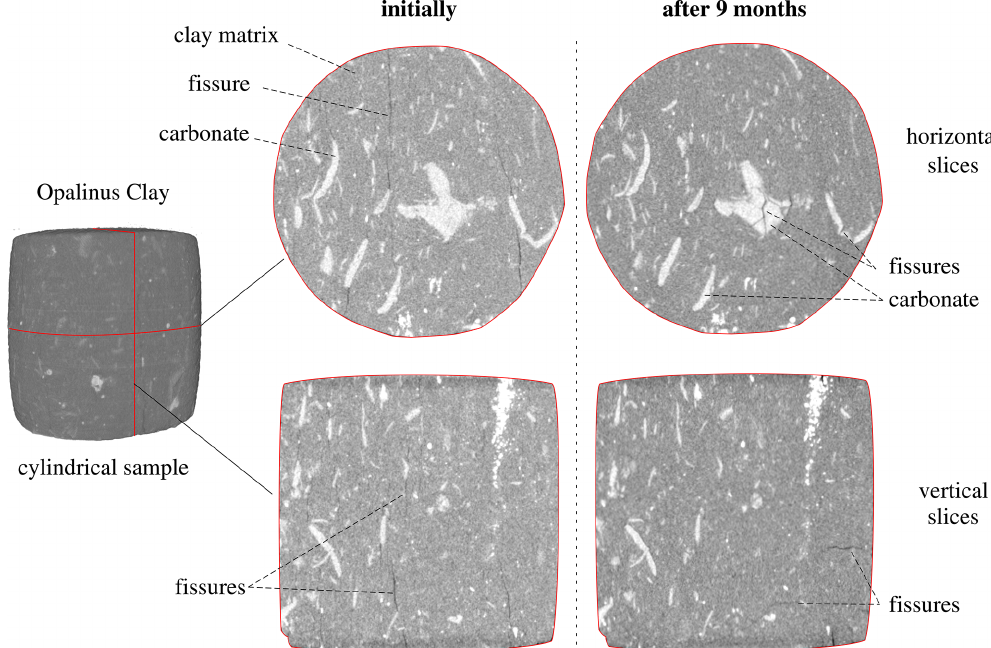
Figure 3. Horizontal and vertical slices of X-ray tomography on the same Opalinus Clay sample with highlighted fissures (in black) under unconfined conditions at its initial state (left) and after 9 months of CO 2 exposure (right). The horizontal slices (top) highlight the fissuring of the carbonate phase due to dissolution and the self-sealing of the pre-existing fissures in the clay matrix under long-term confinement; the vertical slices (bottom) highlight the fissure rearrangement and change in orientation that took place in time.